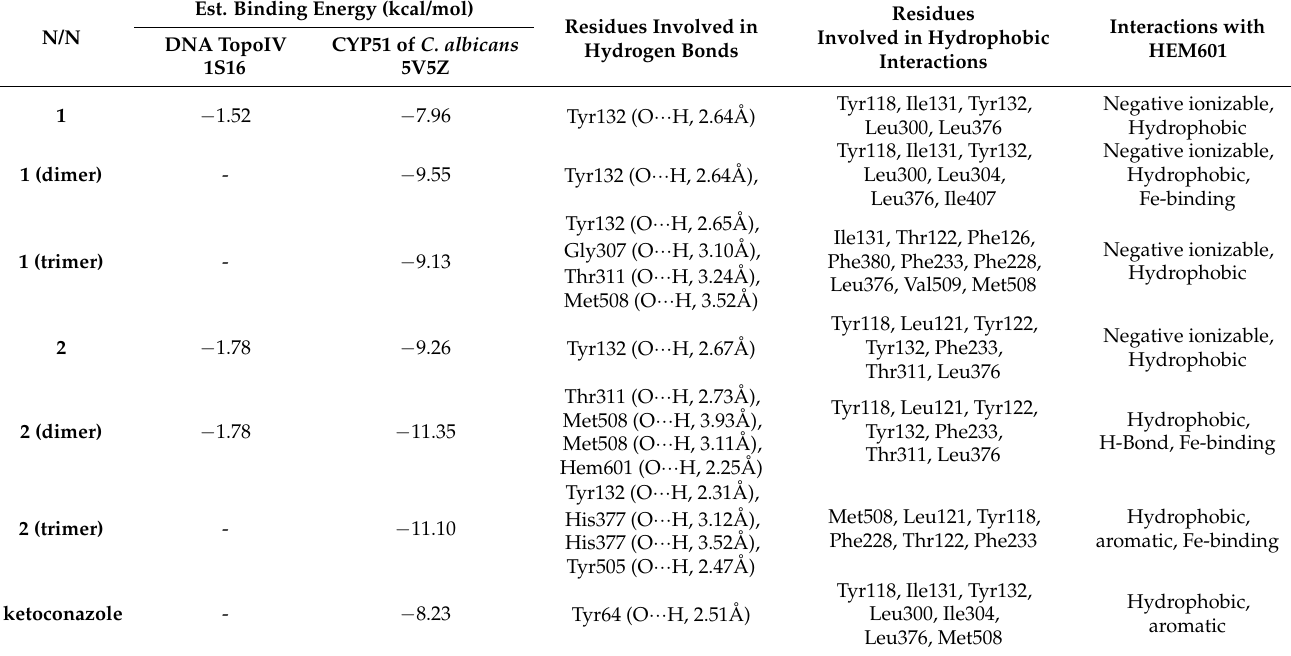
Table 5. Molecular docking binding affinities to antifungal